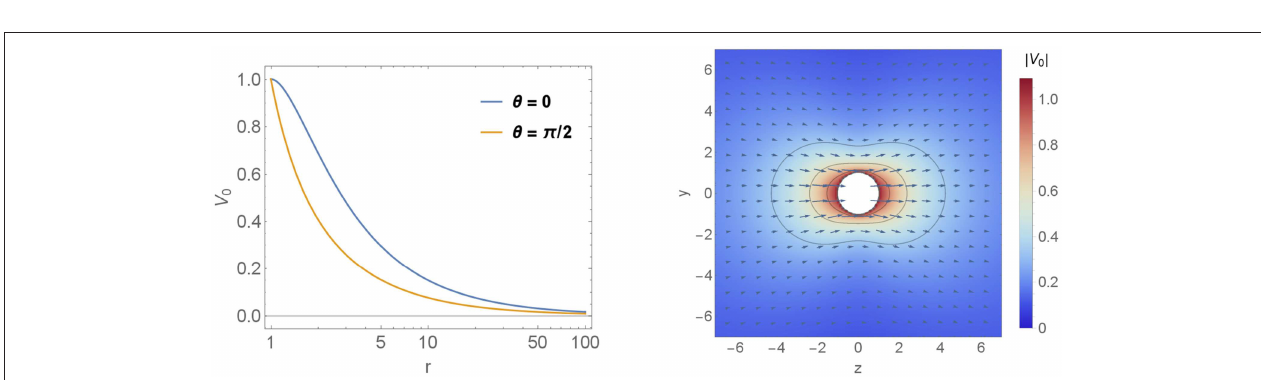
FIGURE 5 | Axisymmetric, quadrupolar viscosity variation Q = [( − 1,0,0),(0, − 1,0),(0,0,2)] / 2 around a spherical particle with length scale decay (A) d 2 = 0.3 and (B) d 2 = 7.